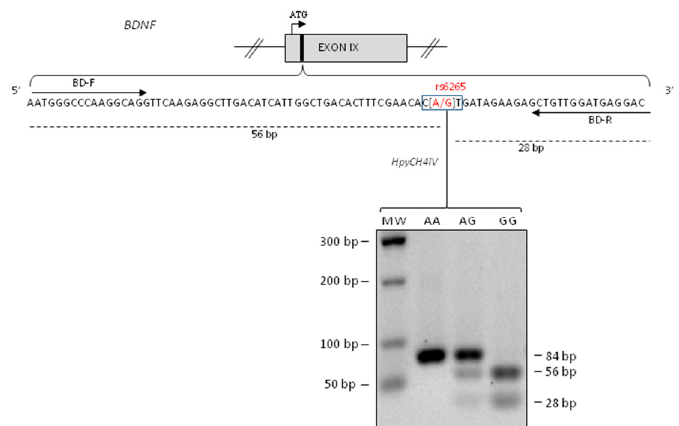
Figure 1. Brain Derived Neurotrophic Factor ( BDNF) rs6265 polymorphism genotyping. Upper panel: schematic representation of human BDNF exon IX (the roman numerals indicate the exon number). The translational (ATG) start site is indicated as an arrow and the region containing rs6265 SNP as a black box. Lower panel: the BDNF sequence amplified by PCR using BD-F and BD-R are indicated as arrows [36] while the restriction fragments of HpyCH4IV restriction enzyme as dashed lines. Lower panel: Electrophoresis on 2% agarose gels of PCR fragments after HpyCH4IV digestion. One PCR product of 84 bp indicated homozygous A / A allele, three PCR fragments of 84 bp, 56 bp and 28 bp indicated heterozygous A / G and two PCR products of 56 bp and 28 bp indicated homozygous G / G allele. The size of molecular the weight (MW) markers of the DNA ladder are in the left